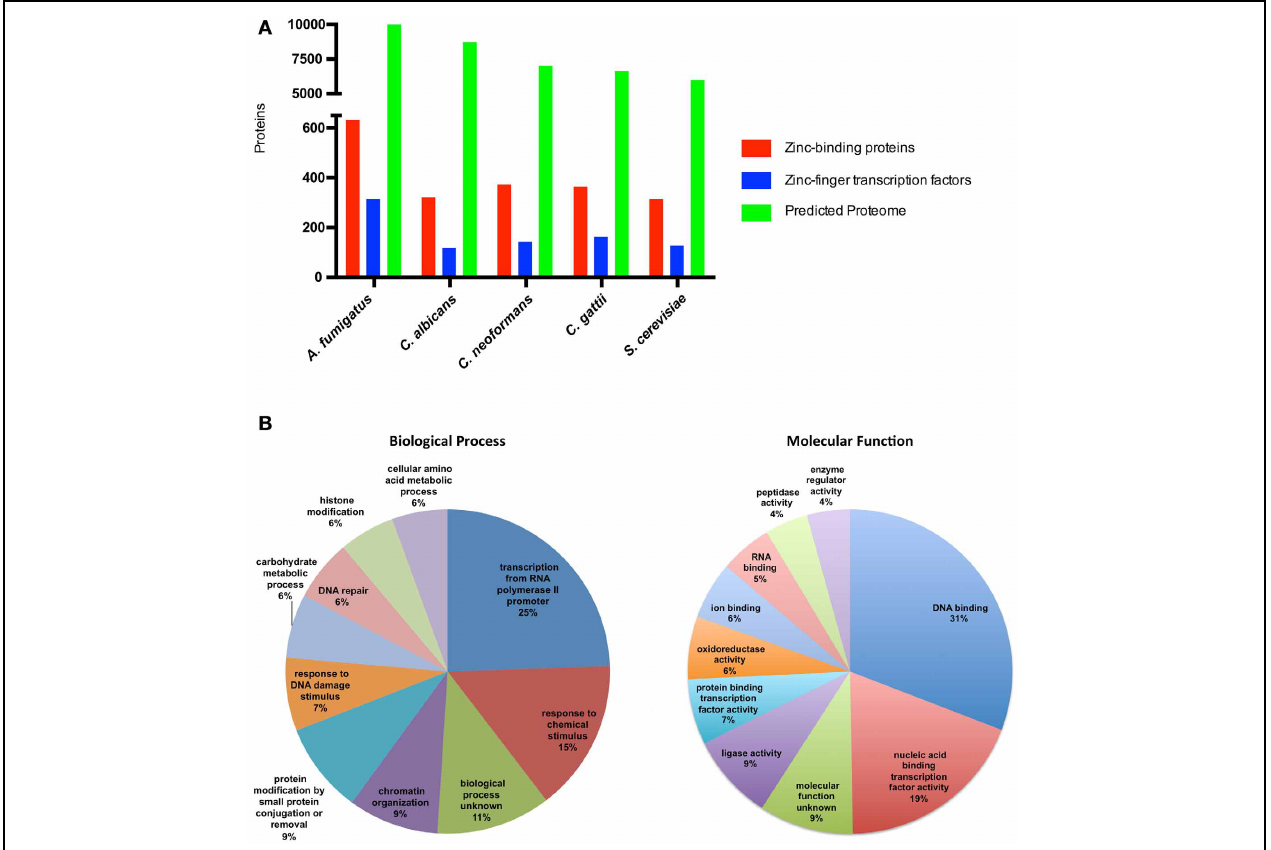
were submitted to the UFO webserver (Meinicke, 2009) for functional profiling. All proteins with the Gene Ontology annotation “zinc ion